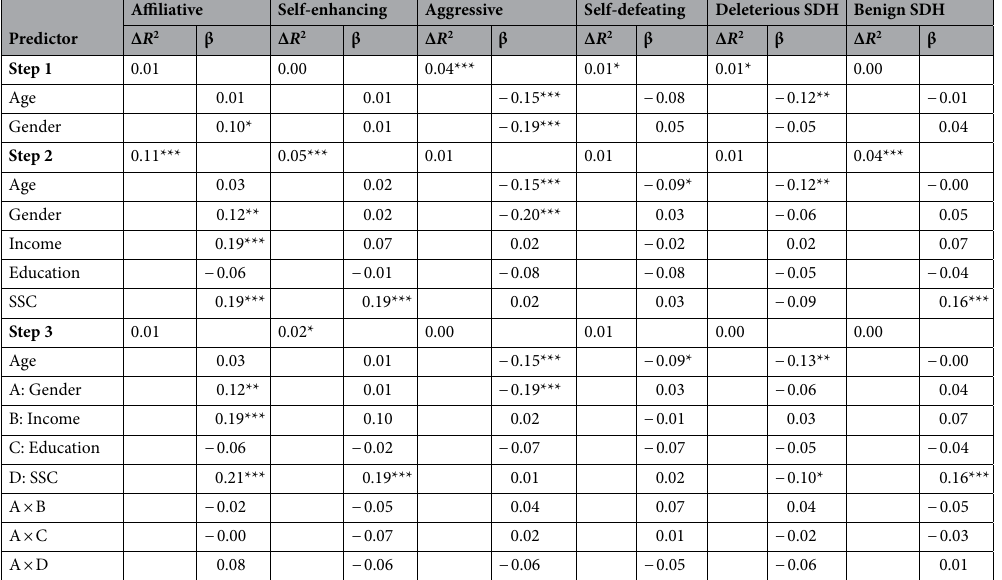
Table 4. Hierarchical multiple regression analysis to predict six types of humor. N = 607. SSC subjective social class. * p < 0.05. ** p < 0.01. *** p <